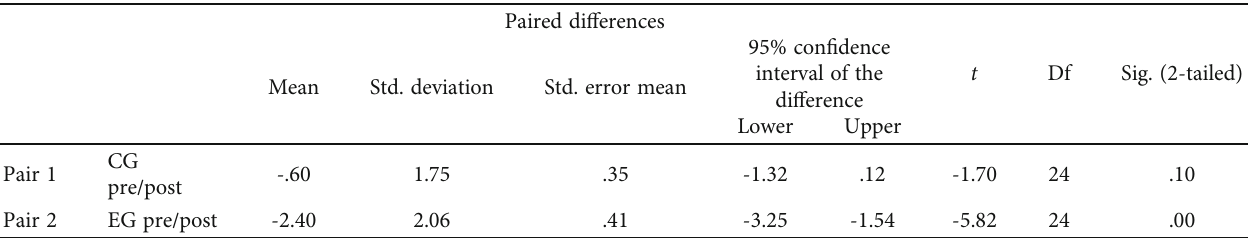
Table 5: Paired samples ’ t -test: comparing the idiom pre- and posttests of each group.